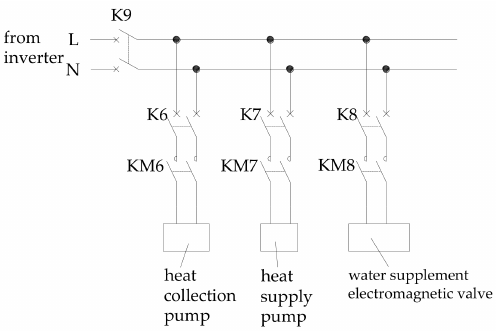
Figure 3. Schematic diagram of electrical control